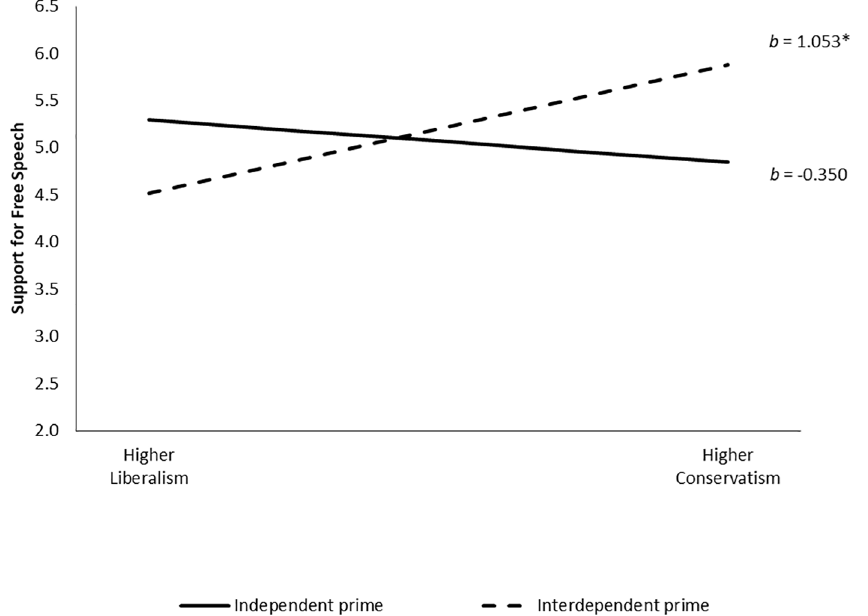
Figure 2. Mean values for participants’ free speech subscale scores based on experimental condition and mean-centered self-ratings of political orientation (Study